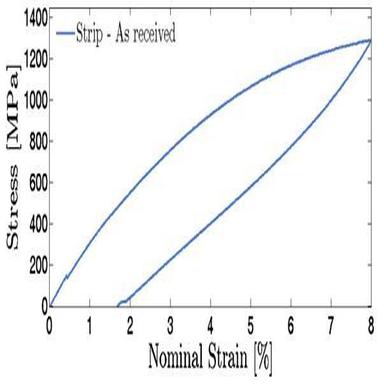
Stress-strain curve of strip as received.